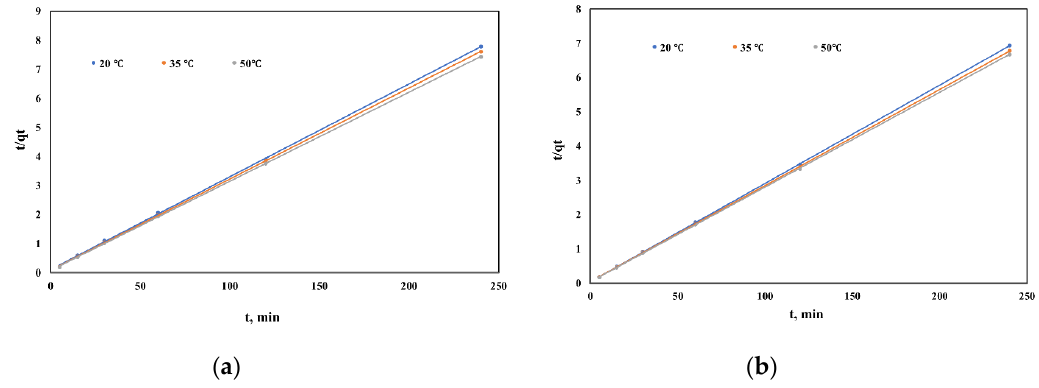
Figure 7. Pseudo-second-order kinetic model of MoO 42− adsorption onto ( a ) Mg 4 Fe and ( b ) Mg 4 Fe-450.